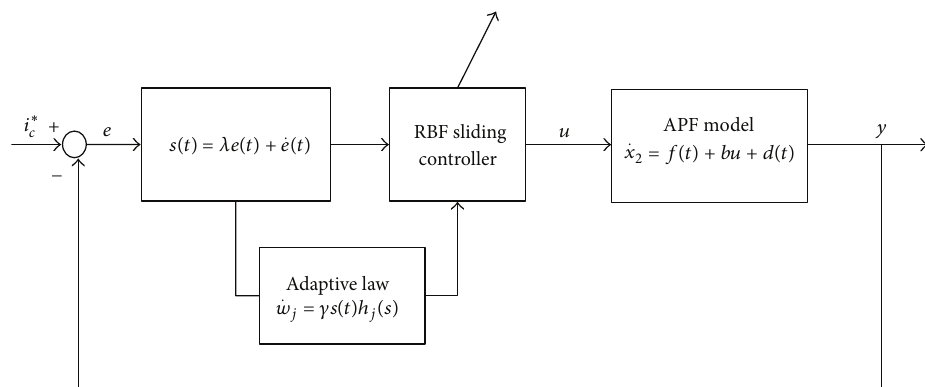
Figure 2: Block diagram of adaptive RBF sliding mode control